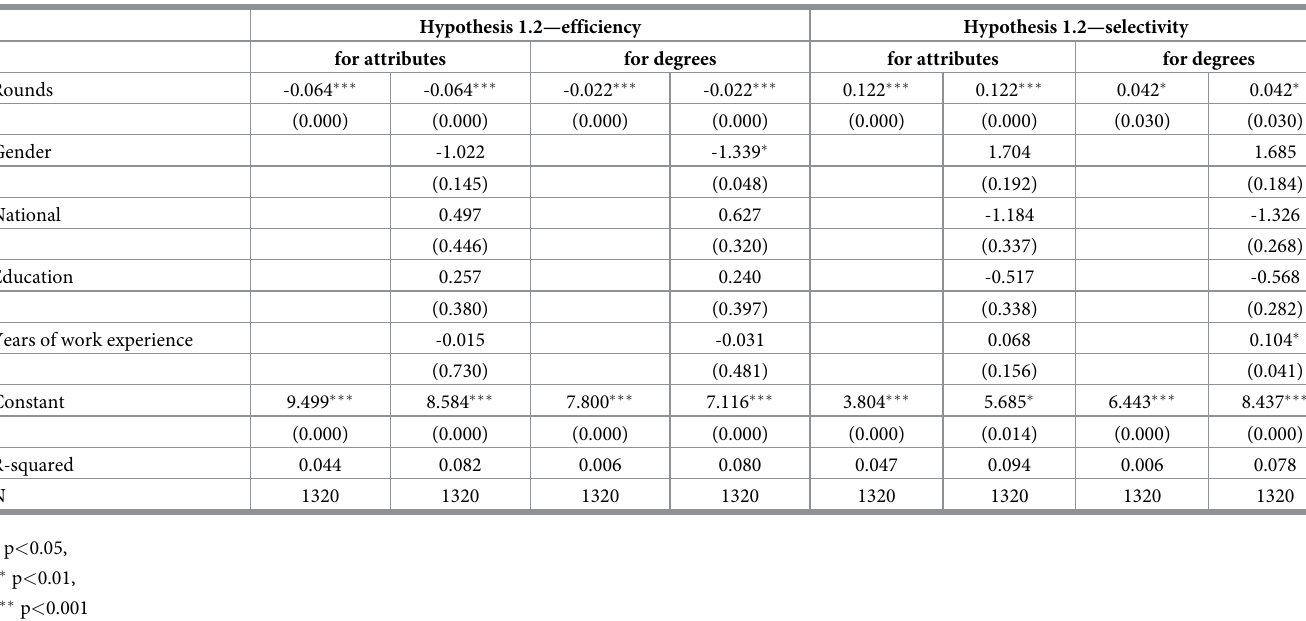
Table 2. Regression table H1. Random effects regression models for both attributes and degrees covering hypothesis 1.1 and hypothesis 1.2 (p-values within